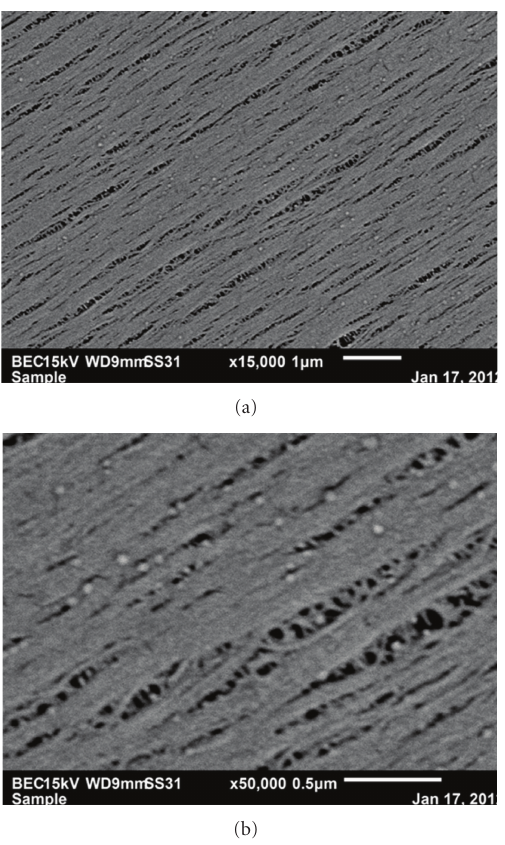
Figure 2: (a) Morphology of the pores in contact with the blood at 15,000x. (b) Morphology of the pores in contact with the blood at 50,000x